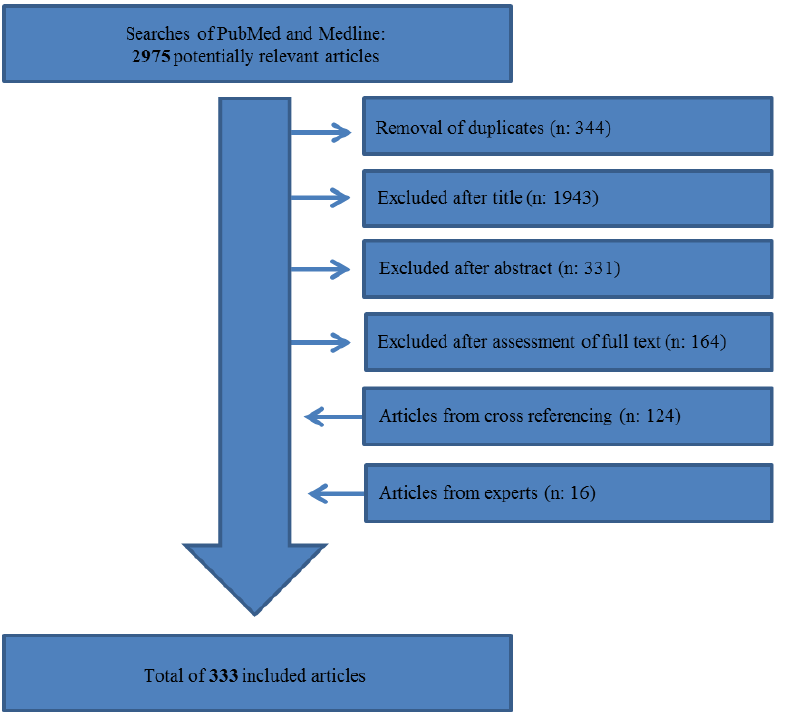
Figure 1. Selection process of relevant